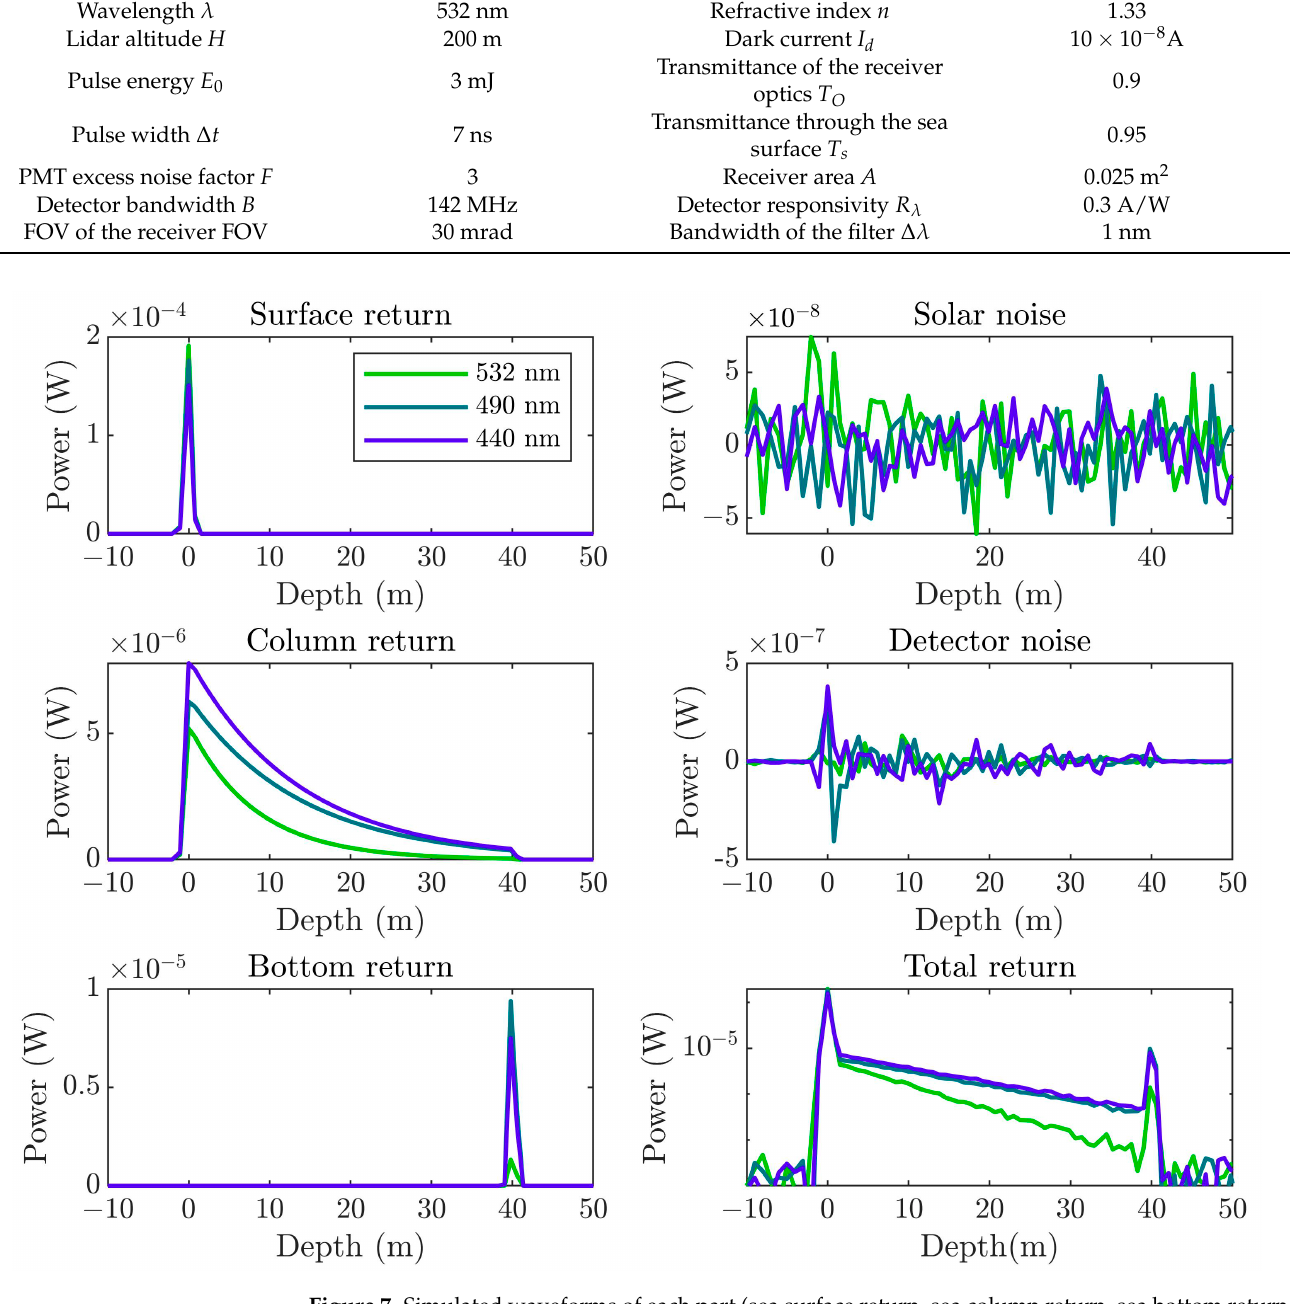
Figure 7. Simulated waveforms of each part (sea surface return, sea column return, sea bottom return, solar background noise, detector shot noise, and total return signal, respectively) in clear water with a chlorophyll concentration of 0.1 mg/m 3 with HawkEye system parameters.